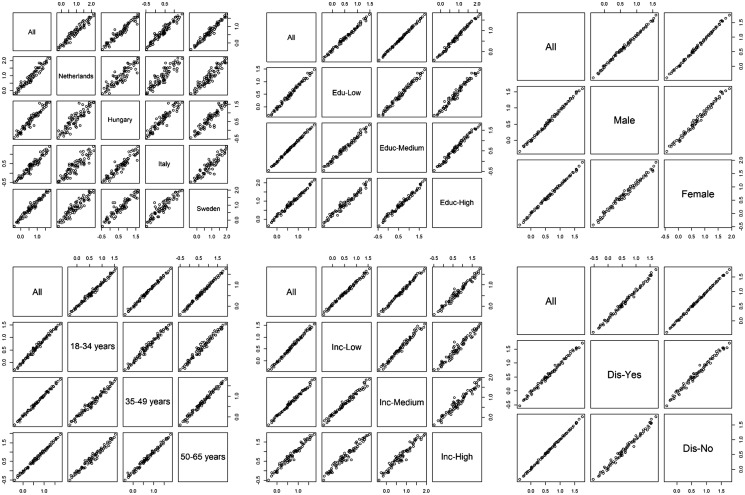
Correlation matrix of probit coefficients by country, educational level, sex, age, income level and disease experience status